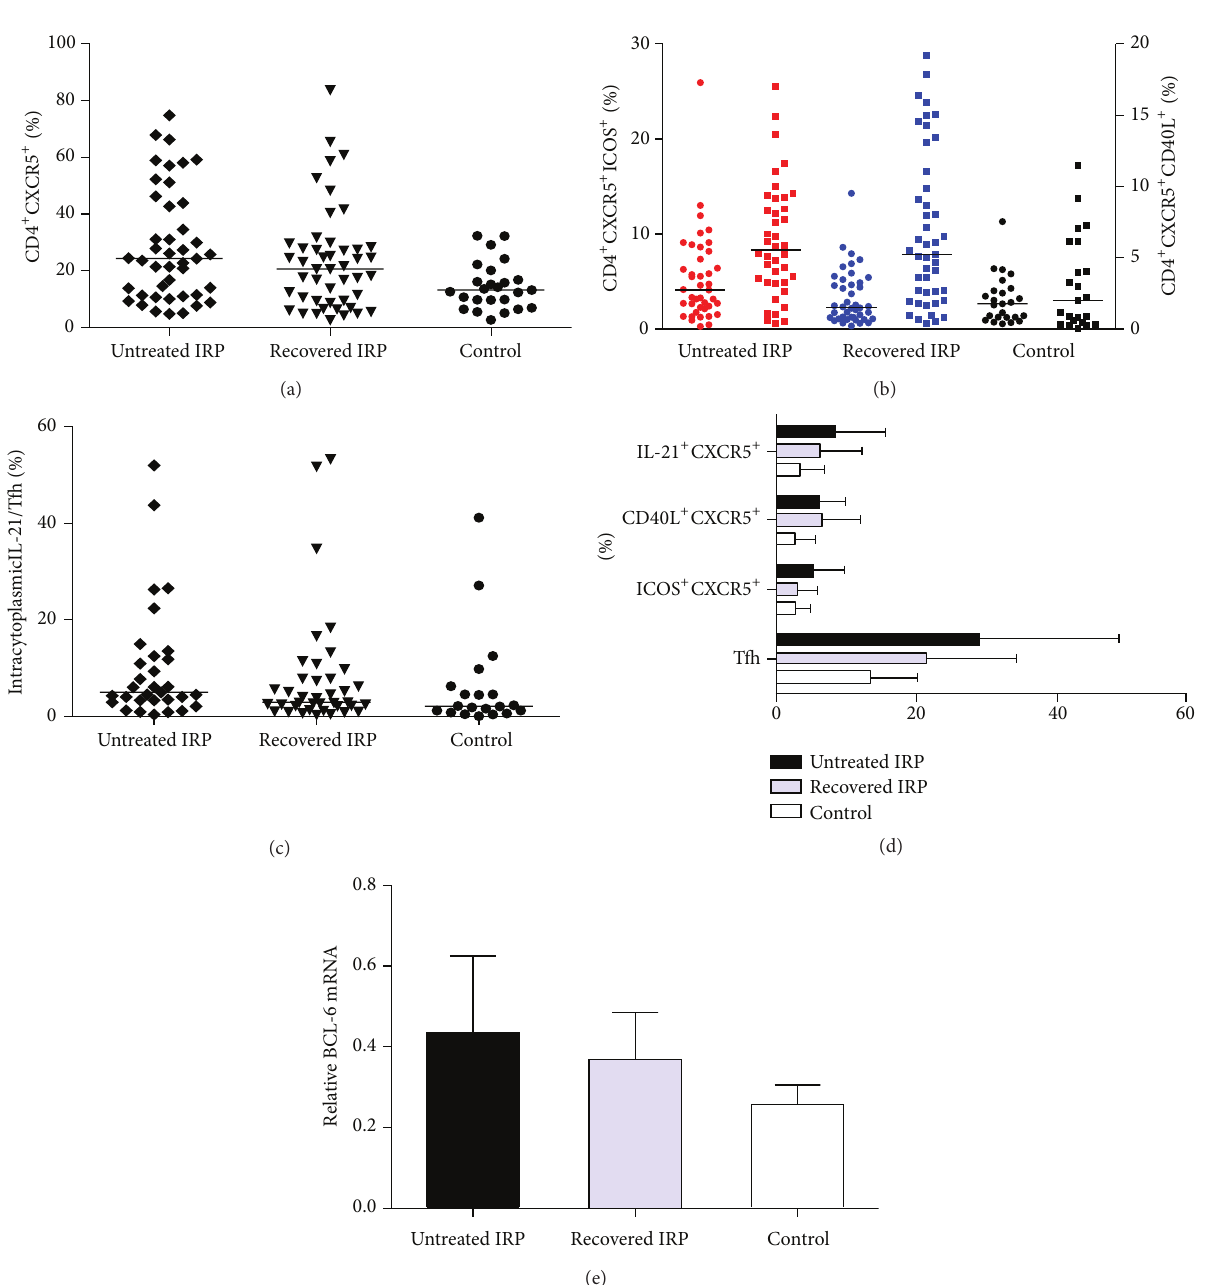
Figure 3: Summary of FACS analysis of BM follicular helper T (Tfh) cells from 90 IRP patients and 25 controls. (a) Tfh cells are expressed as a percentage of CD4 + lymphocytes. Each data point represents an individual subject; horizontal lines show the median. Rhombus indicate untreated IRP patients, triangles indicate recovered IRP patients and circles indicate controls. (b) Comparison of ICOS and CD40L expression according to the expression of CXCR5 on CD4 + cells in IRP patients and healthy controls. On the left 𝑦 -axis, circles indicate CXCR5 + ICOS + cells among the CD4 lymphocytes; on the right 𝑦 -axis, squares indicate CXCR5 + CD40L + cells among the CD4 lymphocytes. Each data point represents an individual subject; horizontal lines show the median. Red indicates untreated IRP patients, blue indicates recovered IRP patients and black indicates controls. (c) Percentage of intracytoplasmic IL-21 + CXCR5 + in CD4 cells in IRP patients, and controls. Each data point represents an individual subject; horizontal lines show the median. Rhombus indicate untreated IRP patients, triangles indicates recovered IRP patients and circles indicate controls. (d) Comparison of Tfh cells, IL-21, ICOS, and CD40L expression, according to the expression of CXCR5 on CD4 + cells in IRP patients, and healthy controls. Data correspond to the mean ± SD. (e) Detection of Bcl-6 mRNA expression in IRP patients and healthy controls. Bcl-6 mRNA was estimated by real-time RT-PCR. Data correspond to the mean ±